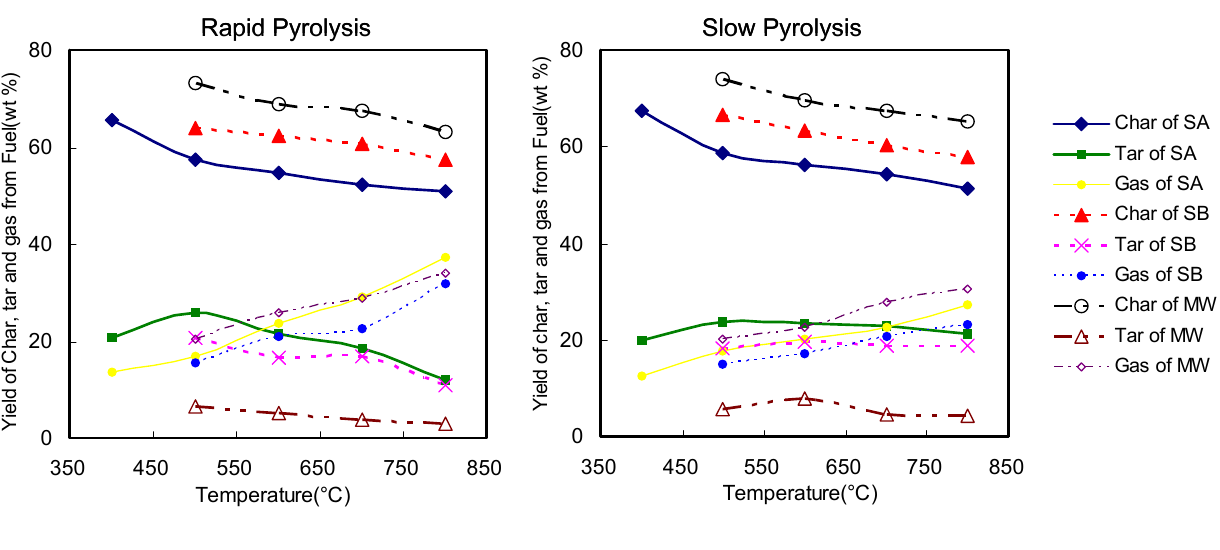
Figure 2. Pyrolysis products as a function of the pyrolysis temperature with two pyrolysis methods: SA is the sludgeA produced in Beijing, SB is the sludgeB produced in Inner Mongolia, MW is the mycelial waste from antibiotic